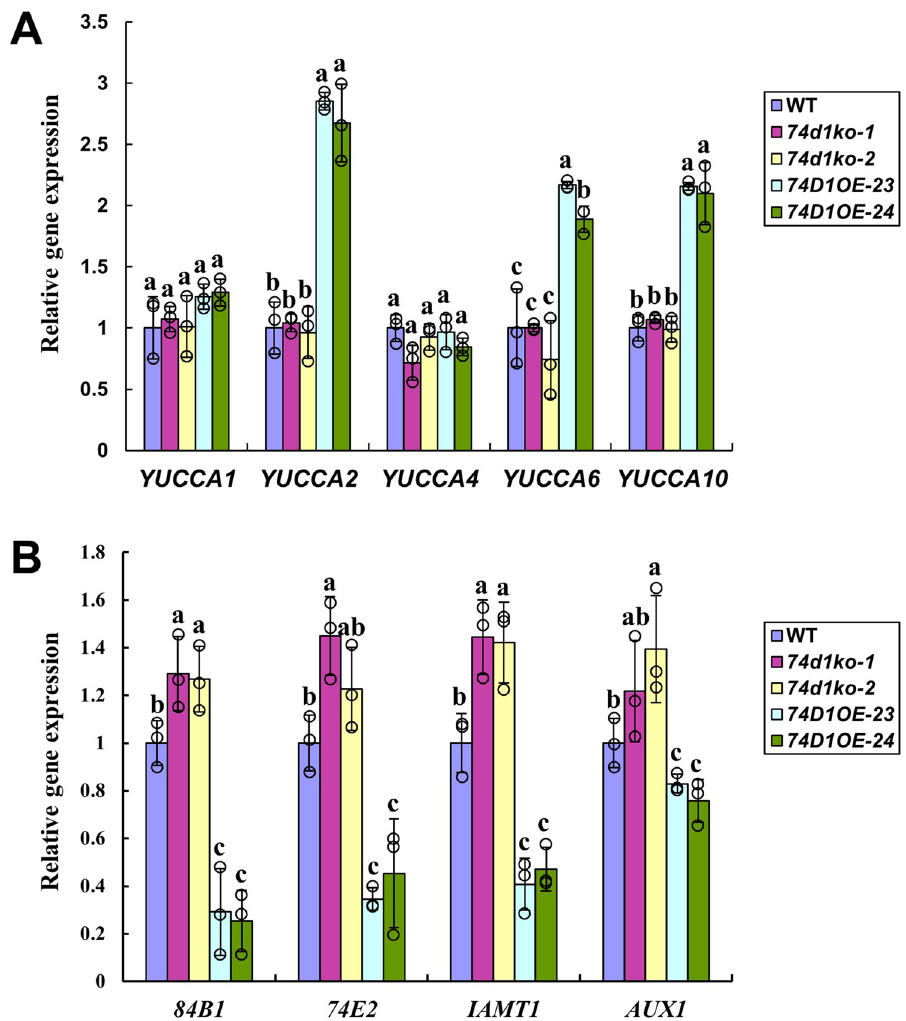
Figure 9. The change of expression level of genes involved in auxin metabolic pathways in UGT74D1 overexpression lines and mutant lines. ( A ) Transcript level of YUCs genes. ( B ) Transcript level of AUX1 , UGT74E2 , UGT84B1 and IAMT1 . The relative transcript level was normalized to the transcript abundance of Actin 2 gene. The statistical significance of the difference was confirmed by ANOVA at α = 0.05 level. Error bars indicate SD from triplicate